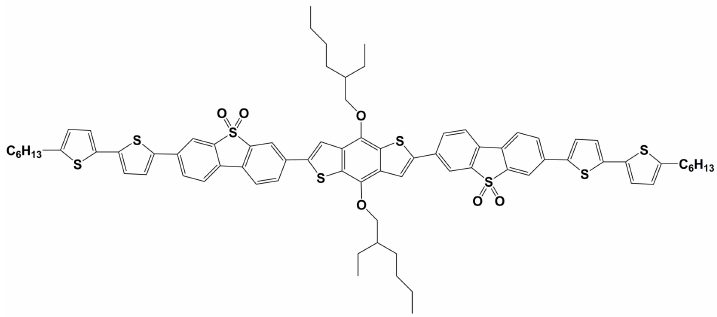
Figure 1. Molecular structure of oligomer BDT(DBTOTTH) 2